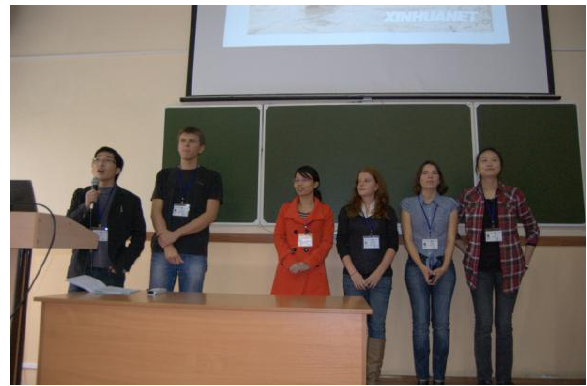
Figure 3. Defending a